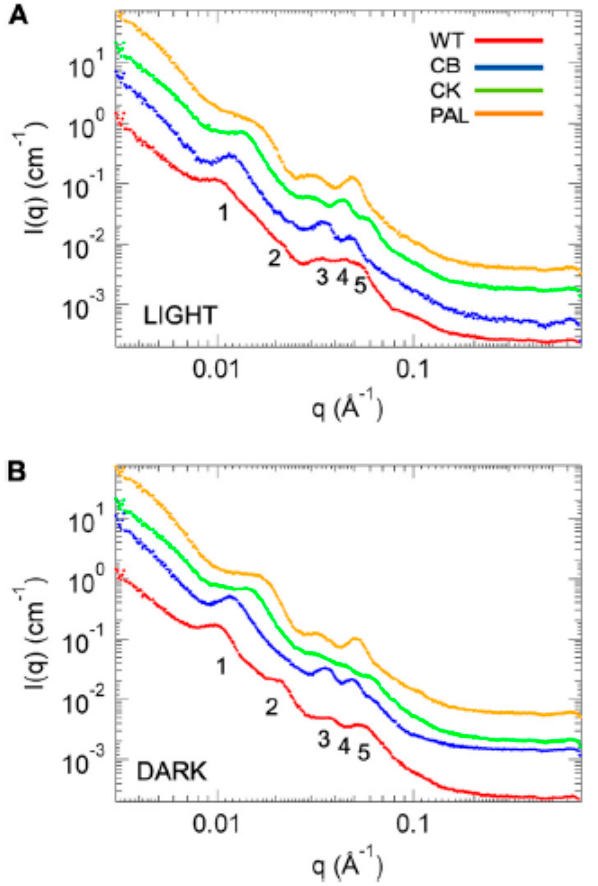
Figure 12. SANS data from the membranes of live cyanobacteria cells in both light and dark condi- tions. WT, CB, CK, and PAL indicate data from different cyanobacteria mutants. The panels marked ( A , B ) show data obtained under light and dark conditions, respectively. There are subtle differences apparent between the two illumination conditions. The numbers indicate the different peaks visible in the spectrum. For a full explanation, one is referred to the original manuscript. Figure adapted and provided by the authors